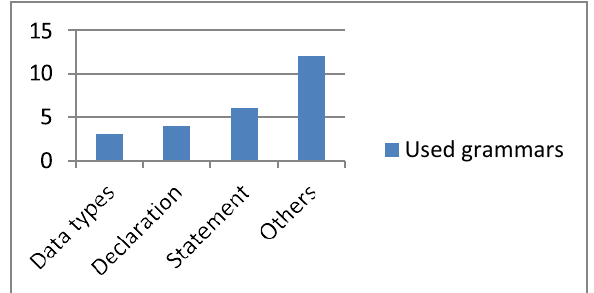
Figure 3. Number of Grammar used